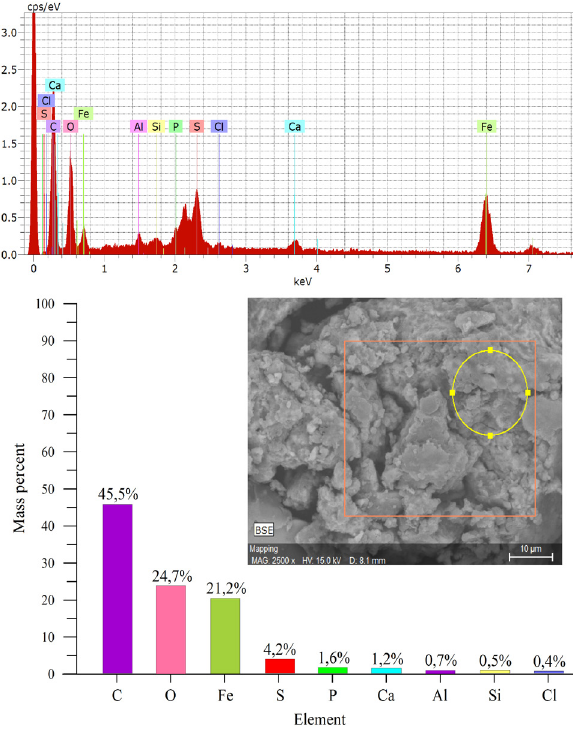
Figure 4: Quantitative analysis of sediment obtained after wastewater treatment with dose 6.0 mL PIX 113 per 1 L.